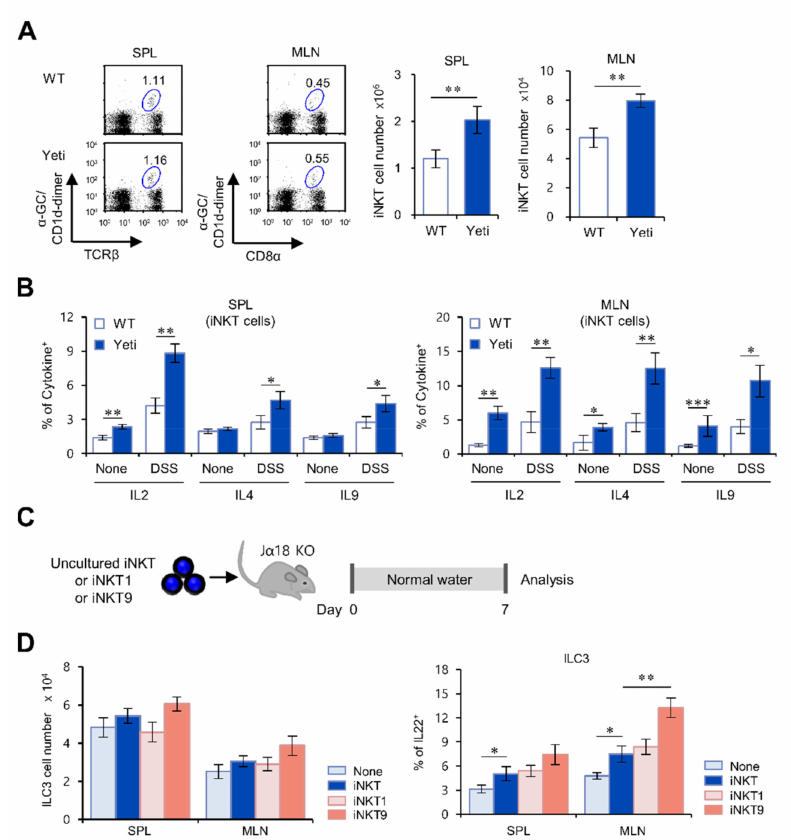
Figure 4. The IL9-producing iNKT cell subset up-regulates IL22-producing ILC3s in IFN γ -mediated intestinal inflammation. ( A,B ) WT and Yeti mice were treated with 1.5% DSS as described in Materials and Methods. The spleen and MLN were collected at ten days after DSS treatment. ( A ) The absolute numbers of iNKT cells in the spleen and MLN from WT and Yeti mice were measured by flow cytometry using α -GalCer-loaded CD1d dimers. Left, representative FACS plots; right, summary. ( B ) The spleen and MLN were obtained from DSS-treated or untreated WT and Yeti mice. Subsequently, the intracellular expression of IL2, IL4, and IL9 by splenic and MLN iNKT cells was determined by flow cytometry. ( C,D ) Sorted MLN iNKT cells from WT mice cultured under iNKT1 (rIL12, rIL2, and anti-IL4) or iNKT9 (rIL4, rTGF β , rIL2, and anti-IFN γ ) conditions. Either iNKT, iNKT1, or iNKT9 (2 × 10 5 ) cells were IV transferred to J α 18 KO mice. The absolute numbers and IL22 production by ILC3s (MHC II + ROR γ t + Lin − ) in the spleen and MLN from these mice were measured by flow cytometry at 7 days after injection. The mean values ± SD ( n = 3 in C and D ; n = 4 in A and B; per group in the experiment; Student’s t -test; * p < 0.05, ** p < 0.01, *** p < 0.001) are